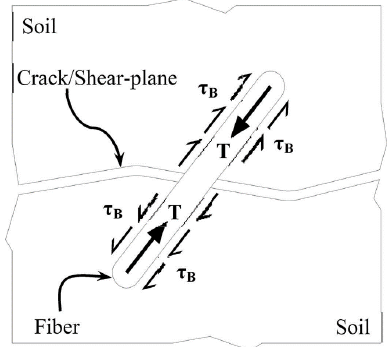
Figure 6. Schematic illustration of fiber–soil interaction (not to scale) [70].